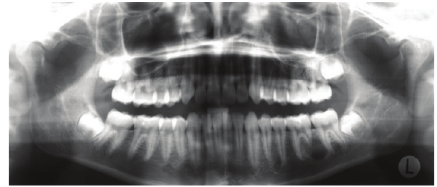
Figure 3: Six-month panoramic radiograph demonstrating no re- currence of lesion, with nascent bone